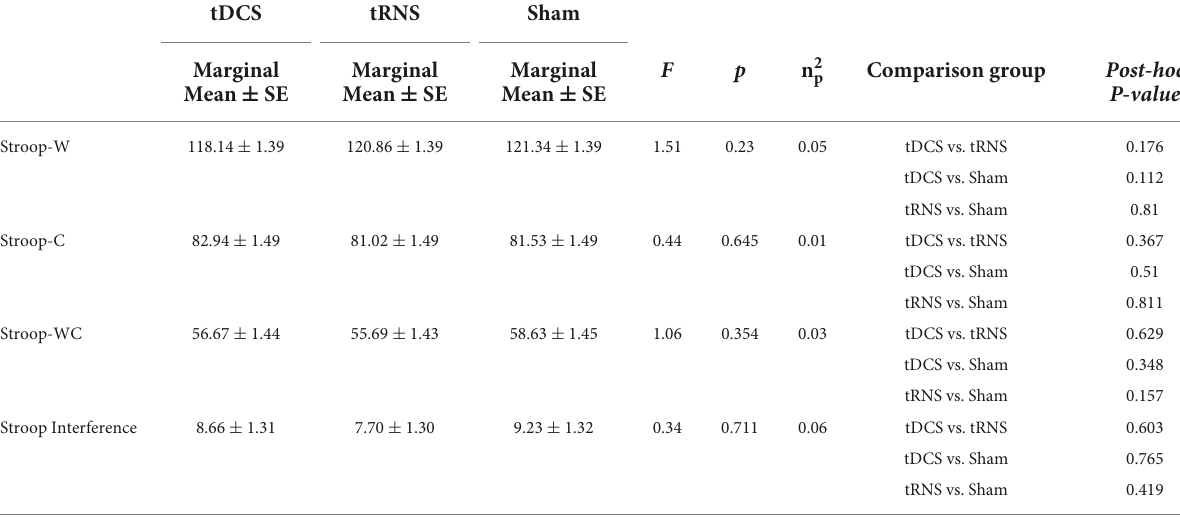
TABLE 4 Differences among groups in Stroop scores during stimulation after controlling for baseline